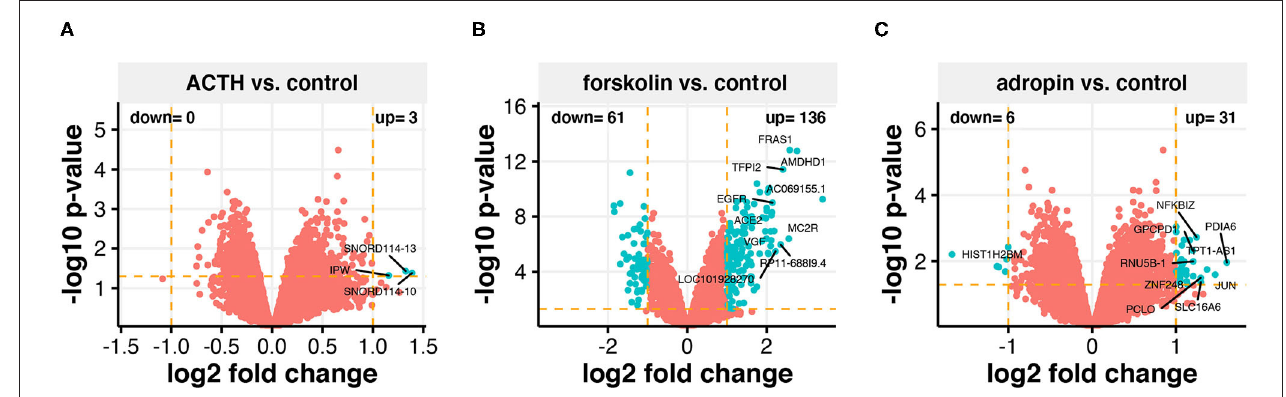
FIGURE 6 | Total gene expression profile of the HAC15 cell line after 24h incubation with ACTH (A) , forskolin (B) , and adropin (C) compared to control (untreated) cells. Each dot represents a mean value of the single gene expression ( n = 4/group). Dotted lines indicate cut-off values (two-fold change in expression and p < 0.05 with FDR correction). The red dots represent the genes below the cut-off limit. The turquoise color marks upregulated and downregulated genes. Ten genes with the highest differences within fold change values were labeled with the appropriate gene symbols.